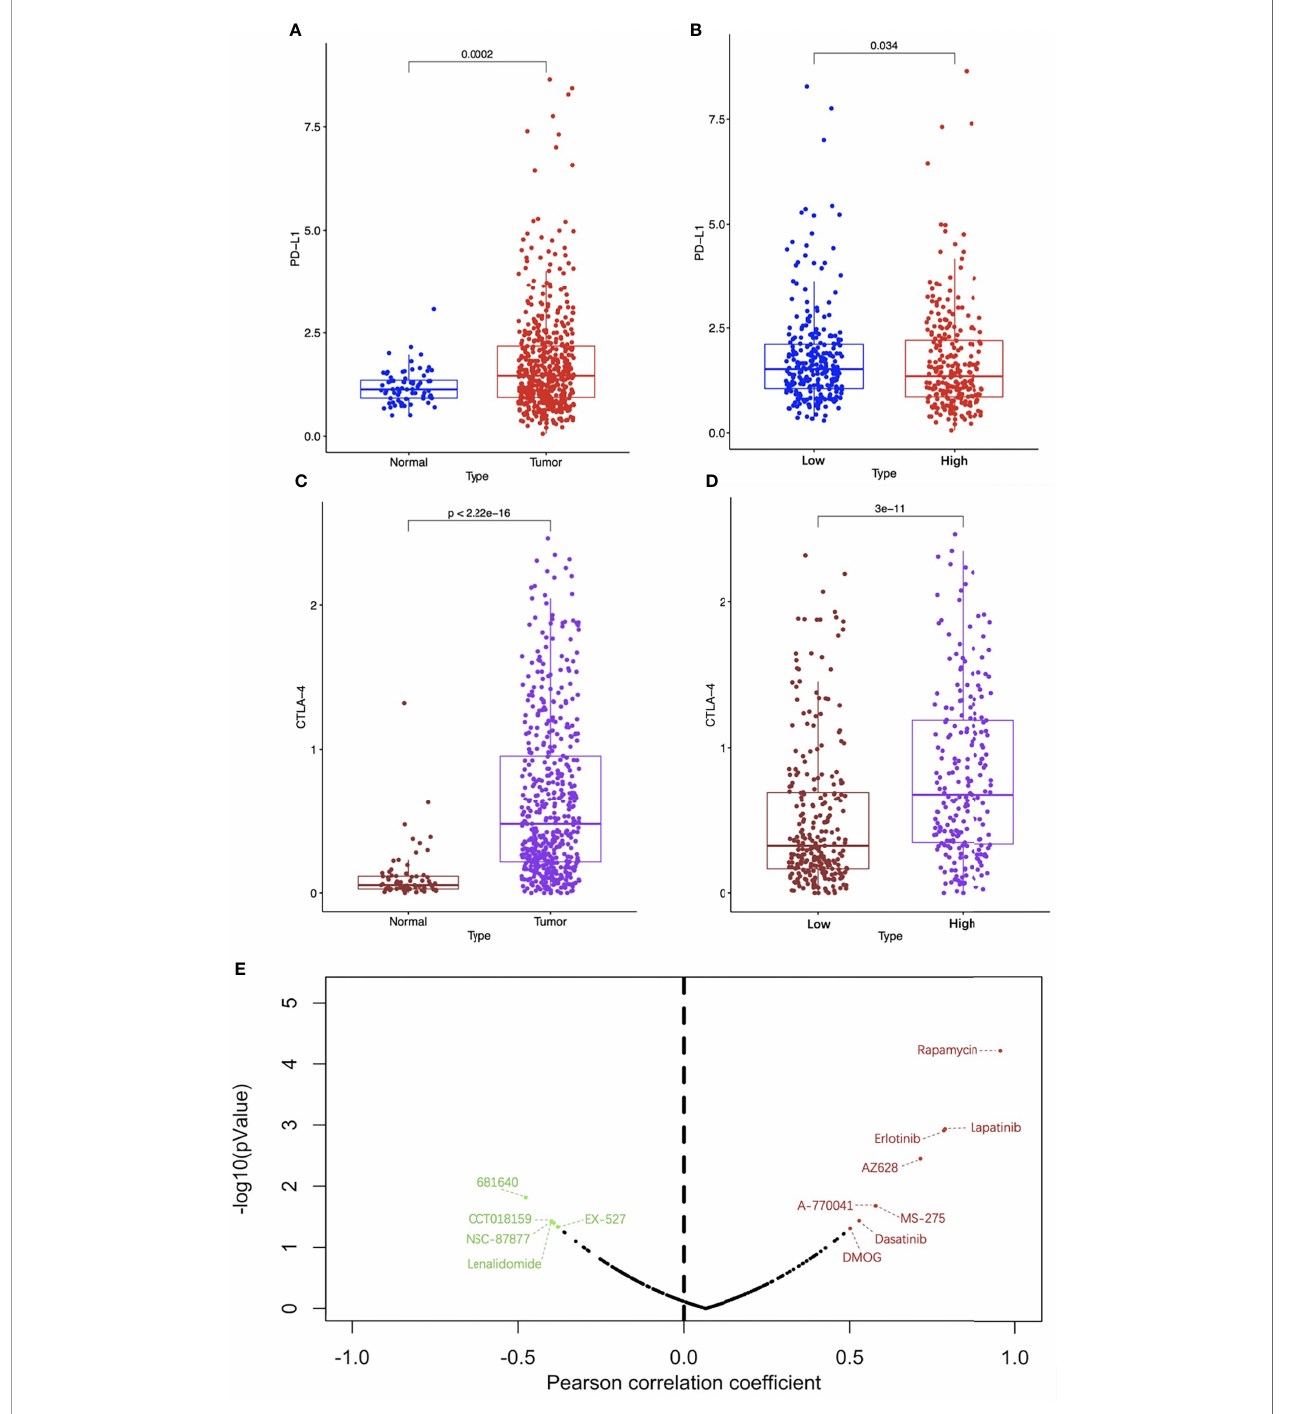
FIGURE 12 | Analysis of immune checkpoint and drug sensitivity. The expression levels of PD-L1 (A) and CTLA-4 (C) between ccRCC and normal specimens. The expression levels of PD-L1 (B) and CTLA-4 (D) between high-risk and low-risk groups. (E) The correlation between traditional anti-tumor drug sensitivity and risk score, the red dots represent drugs whose IC50 were positively correlated with the risk score with p < 0.05 and the green dots represent drugs whose IC50 were negatively correlated with the risk score with p < 0.05. PD-1, programmed death ligand 1; CTLA-4, cytotoxic T lymphocyte associated antigen 4; CcRCC, clear cell renal cell